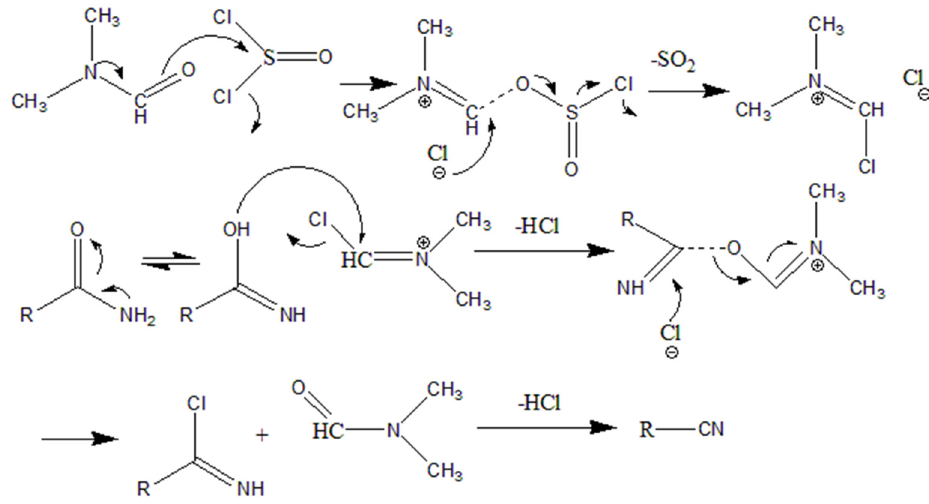
Figure 5. Dehydration reaction of PP ‐ g ‐ PAAm into PP ‐ g ‐ P (AAm ‐ co ‐ AN).